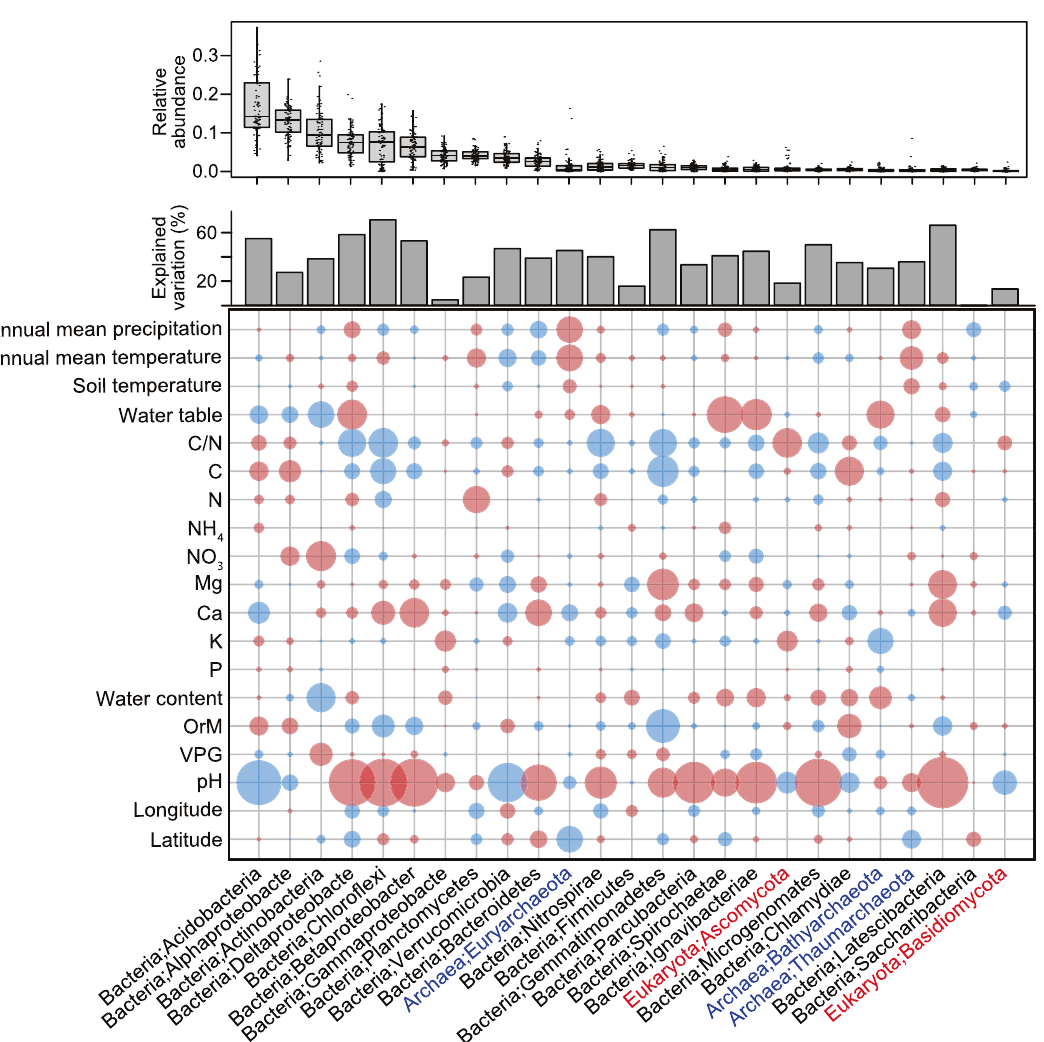
Fig. 2 Environmental predictors of major archaeal, bacterial and fungal phyla (class for Proteobacteria) across the global wetland soils. The relative abundance data are based on the relative abundance of SSU rRNA genes (normalized by total SSU rRNA abundances per sample) as revealed by shotgun metagenomics ( n = 74 independent sites). Boxes represent 25th – 75th percentile of the data distribution with whiskers at 1.5 × the interquartile range and the middle line representing median. The size of circles corresponds to the partial importance based on Random Forest models (variability% of mean decrease in accuracy estimated based on out-of-bag-CV); blue and red depict negative and positive Spearman correlations, respectively ( n = 74 independent sites). Archaeal and fungal phyla names are indicated in blue and red colour, respectively. The abbreviations are organic matter (OrM), pH (soil pH), C/N (carbon to nitrogen ratio), Ca (calcium), K(potassium), P (phosphorous), Mg (magnesium), and Von Post grade of decomposition